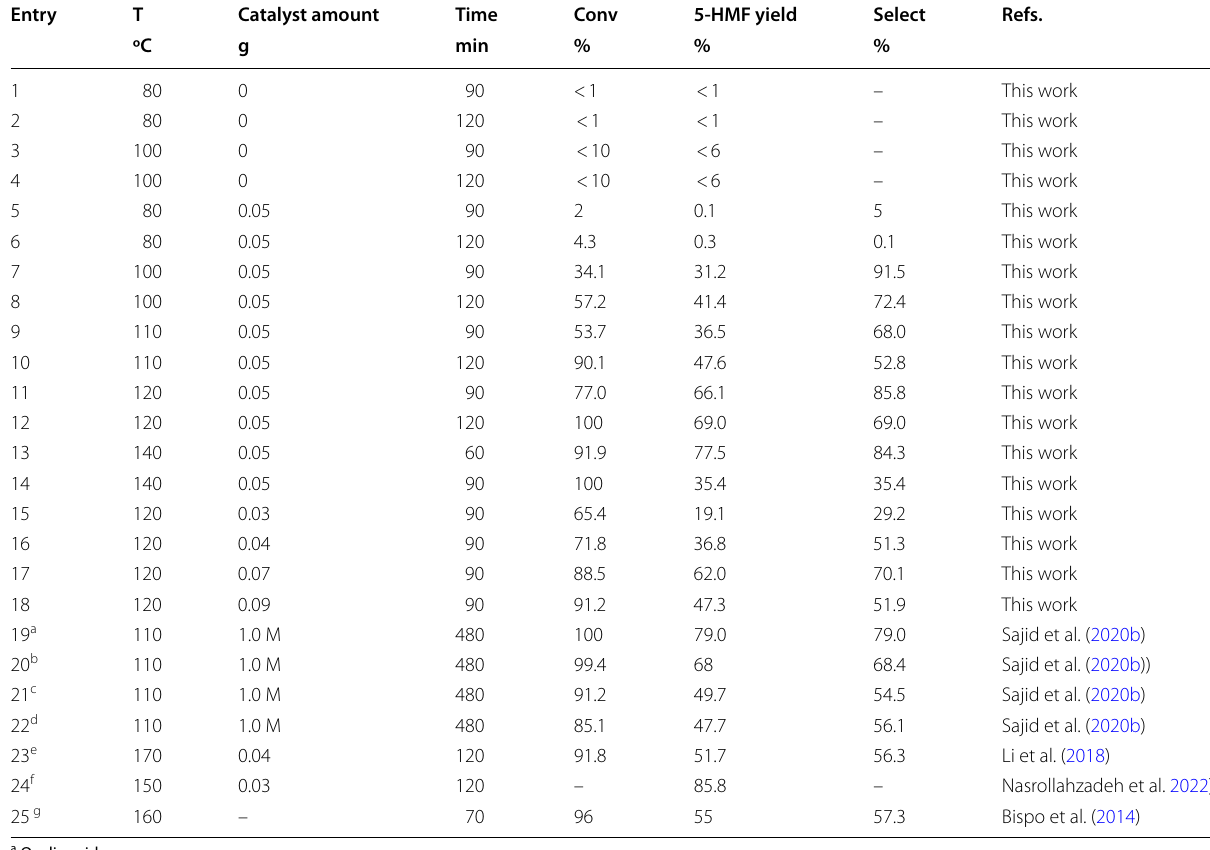
Table 2 Effect of reaction temperature and catalyst dosage on fructose conversion and 5-hydroxymethylfurfual (5-HMF) yield